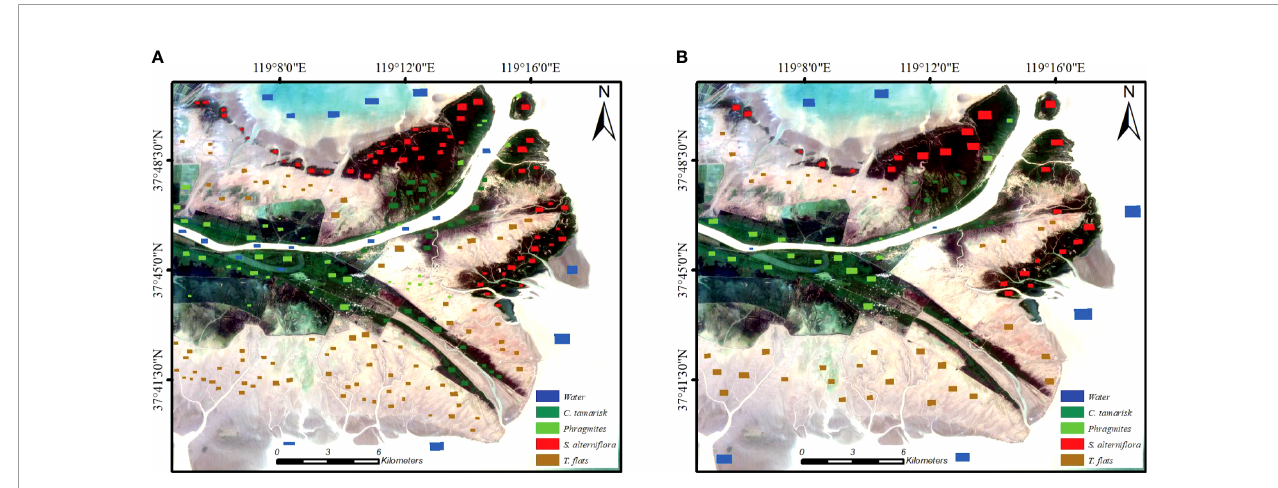
FIGURE 4 | The distribution of samples. The background is the Sentinel-2 true color image, and the imaging time is July 16, 2018. (A) is the distribution of the statistical samples; (B) is the distribution of the veri fi cation